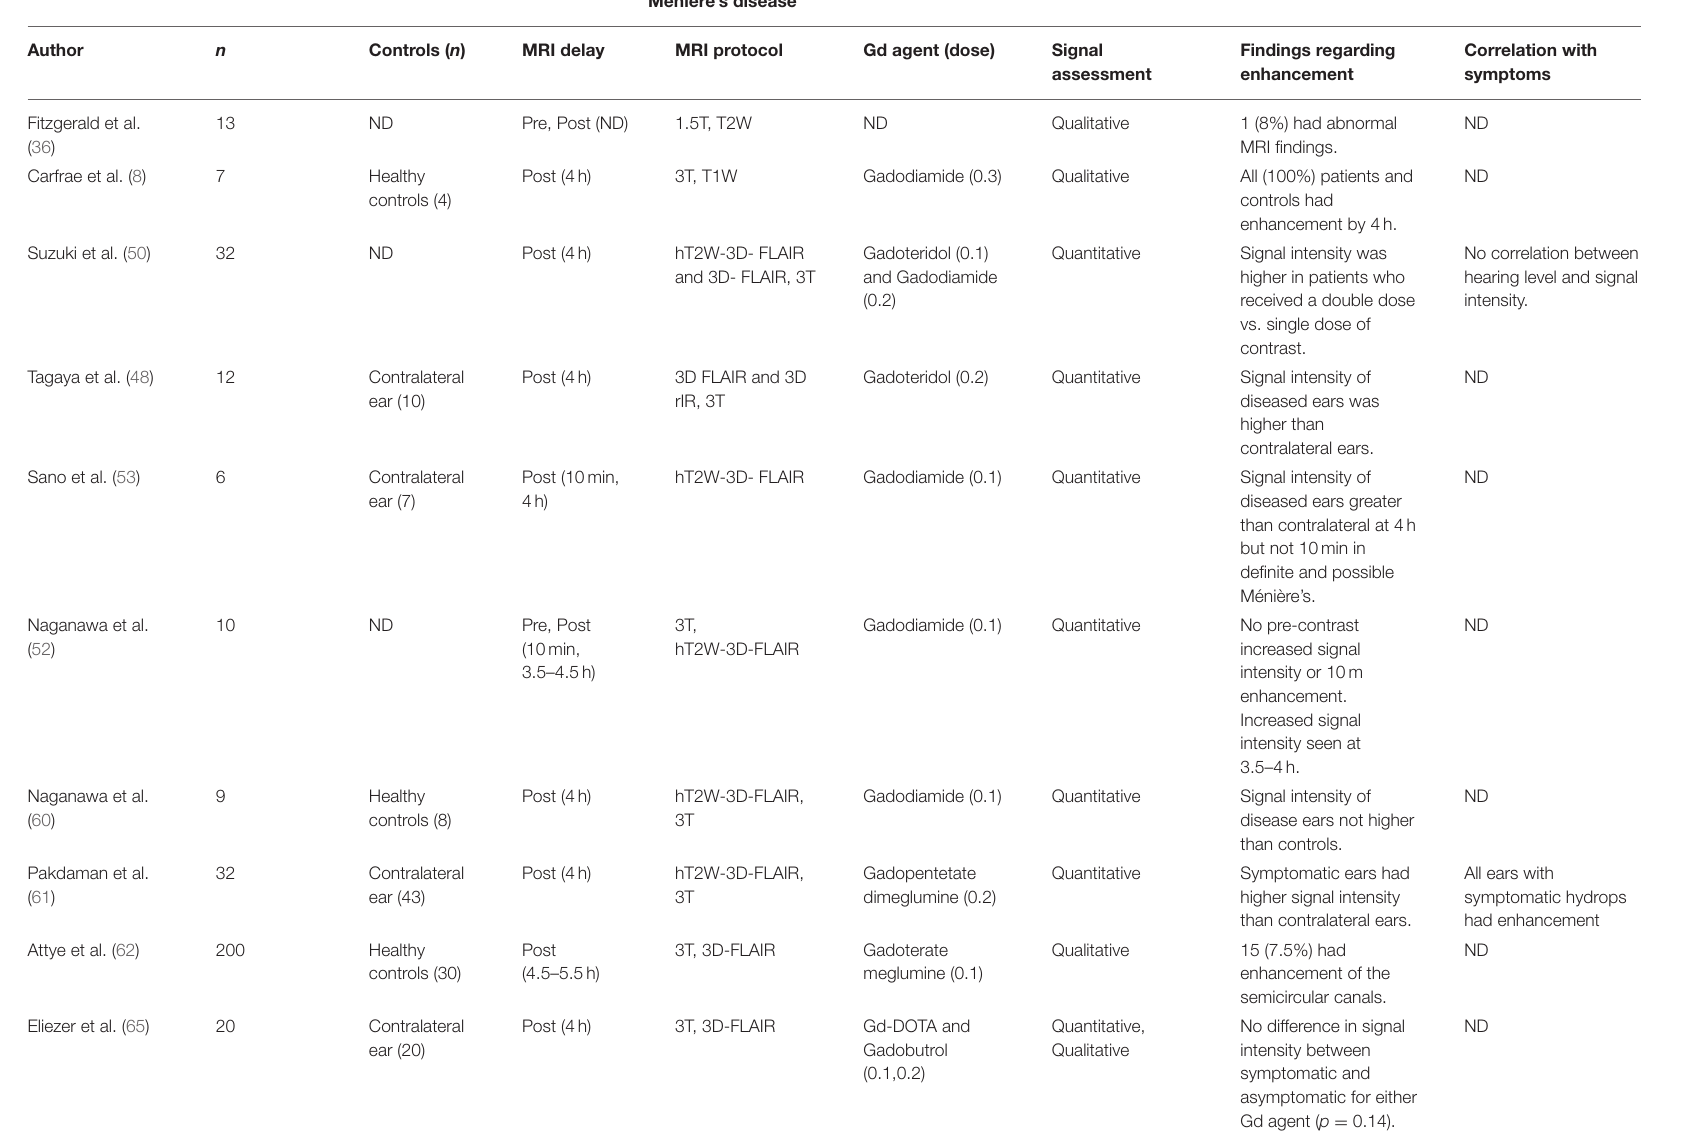
TABLE 4 | Summary of findings in studies of Ménière’s